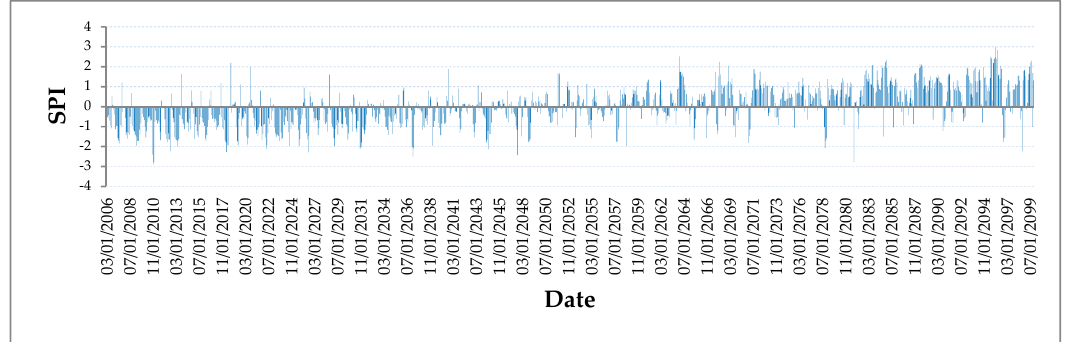
Figure 13. Gulu CanESM2 future average monthly rainfall variations for ( a ) maximum monthly rainfall and ( b ) minimum monthly rainfall.